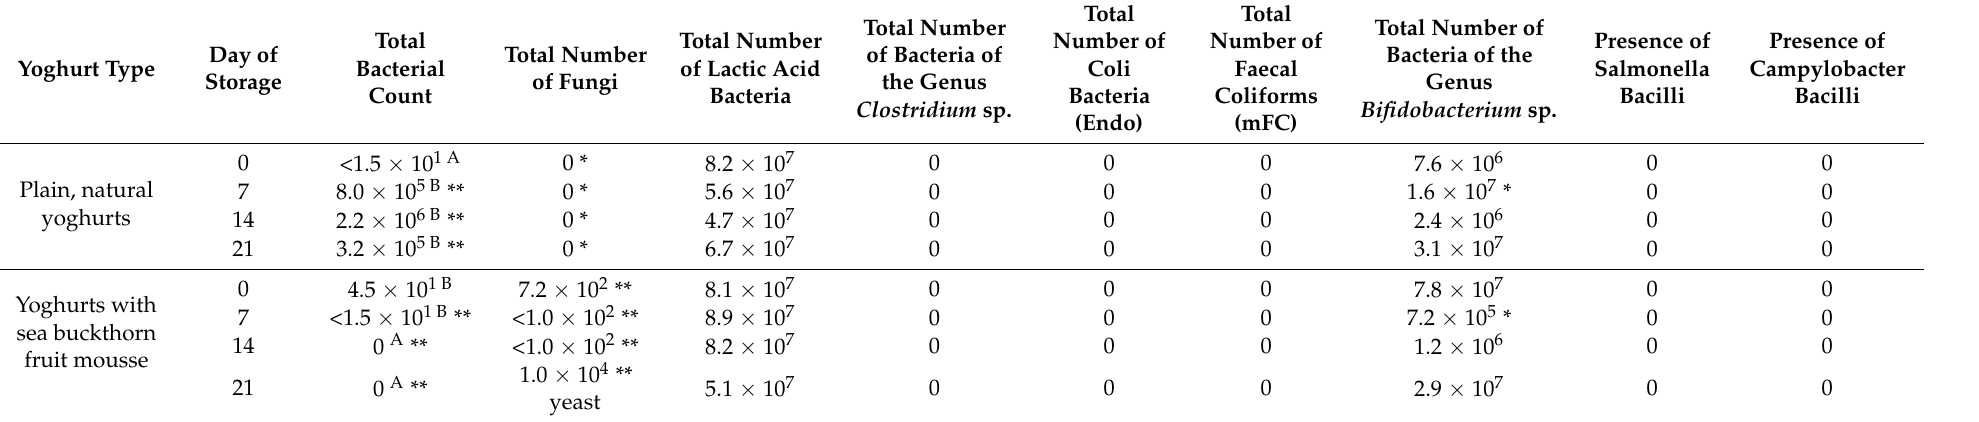
Table 4. Microbiological evaluation of the analysed yoghurts during 21 days of storage in the refrigerated